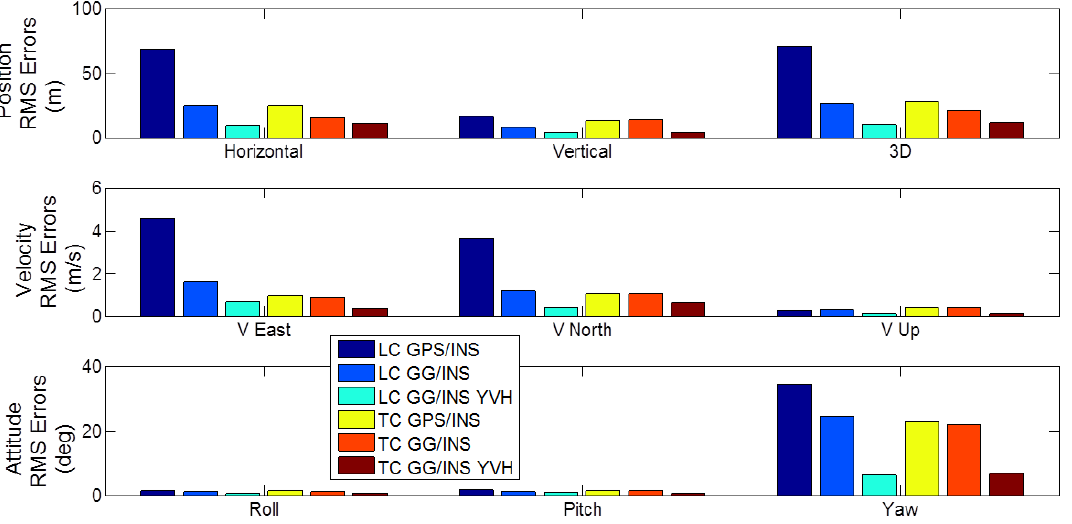
Figure 16. Comparison between LC and TC architectures in terms of position, velocity and attitude RMS errors (Segment